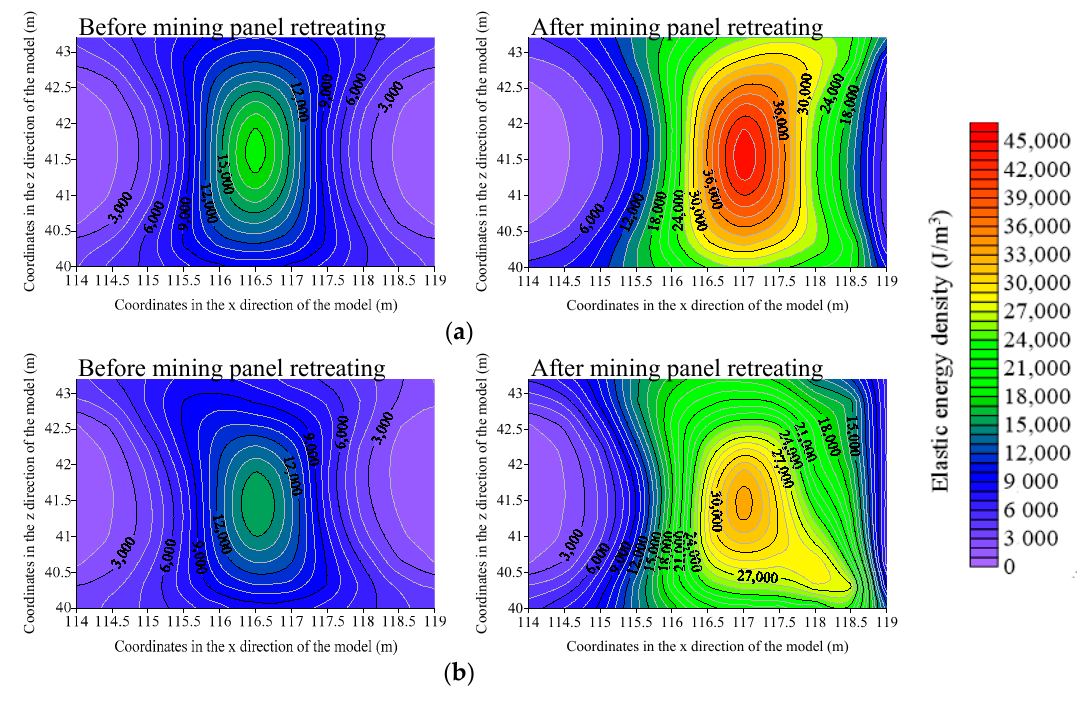
Figure 15. Effect of pre-splitting blasting on the elastic strain energy density of the coal pillar: ( a ) no pre-splitting; ( b ) length of the non-penetrating fracture: 5 m.